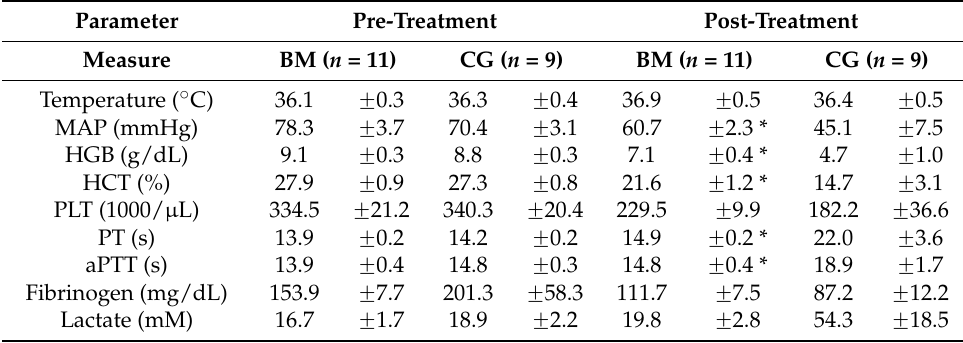
Table 1. Physiological and hematological measurements pre-treatment and post-treatment. Parameter